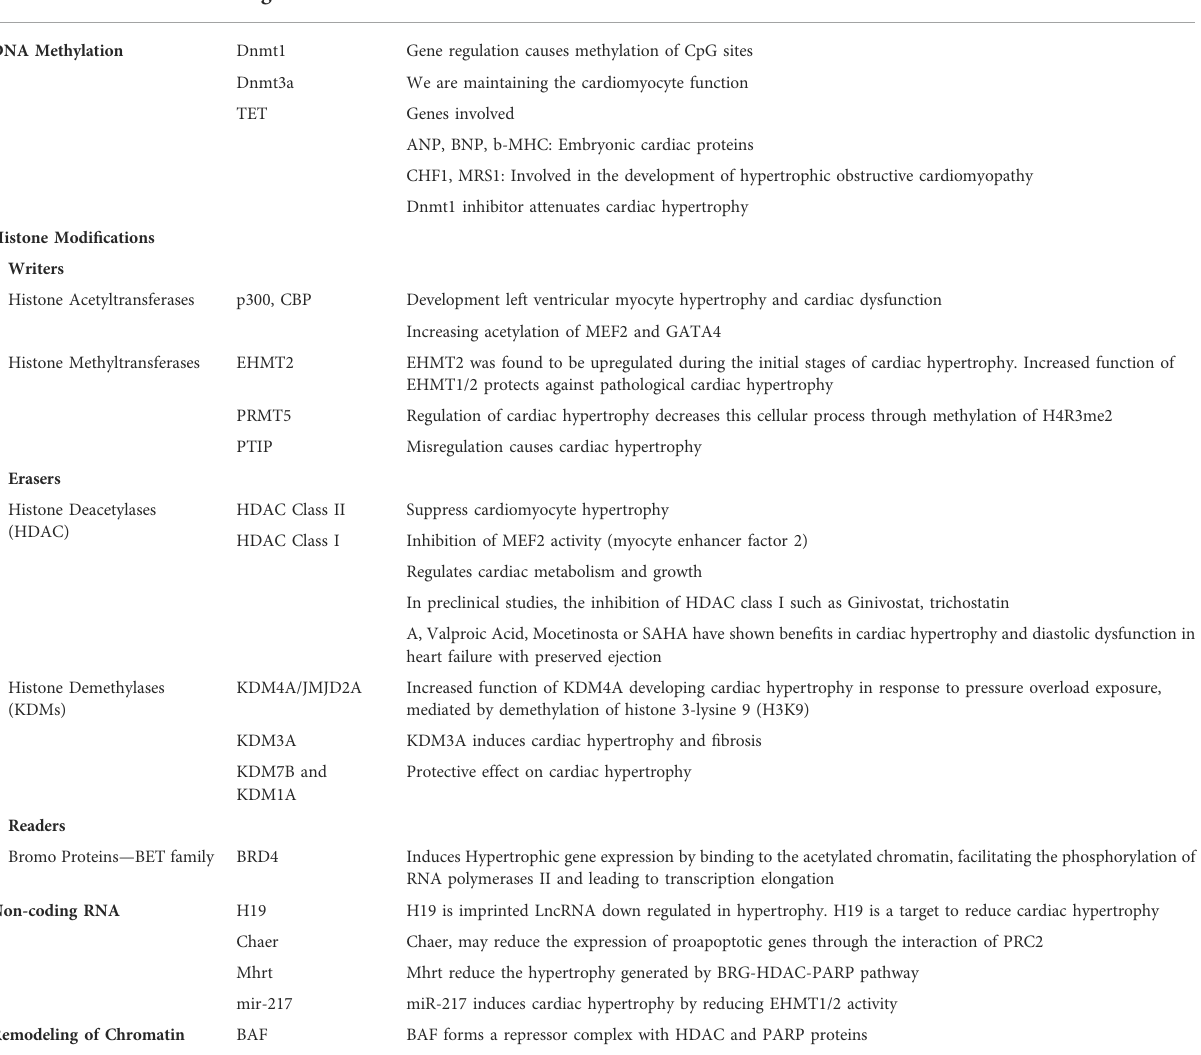
TABLE 1 Epigenetic mechanisms in the development of hypertrophic